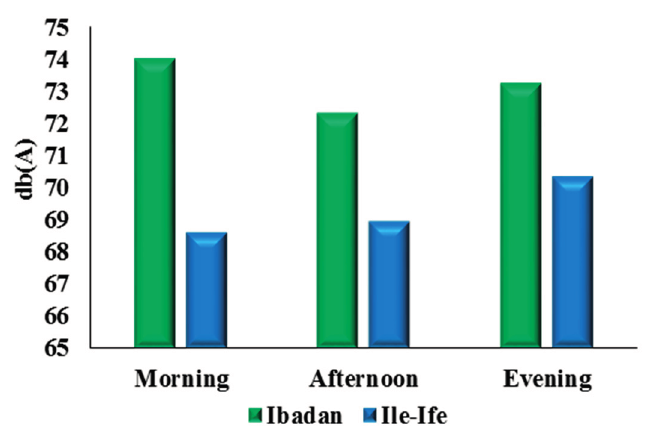
Figure 7. Average daily noise levels in Ibadan and Ile-Ife.